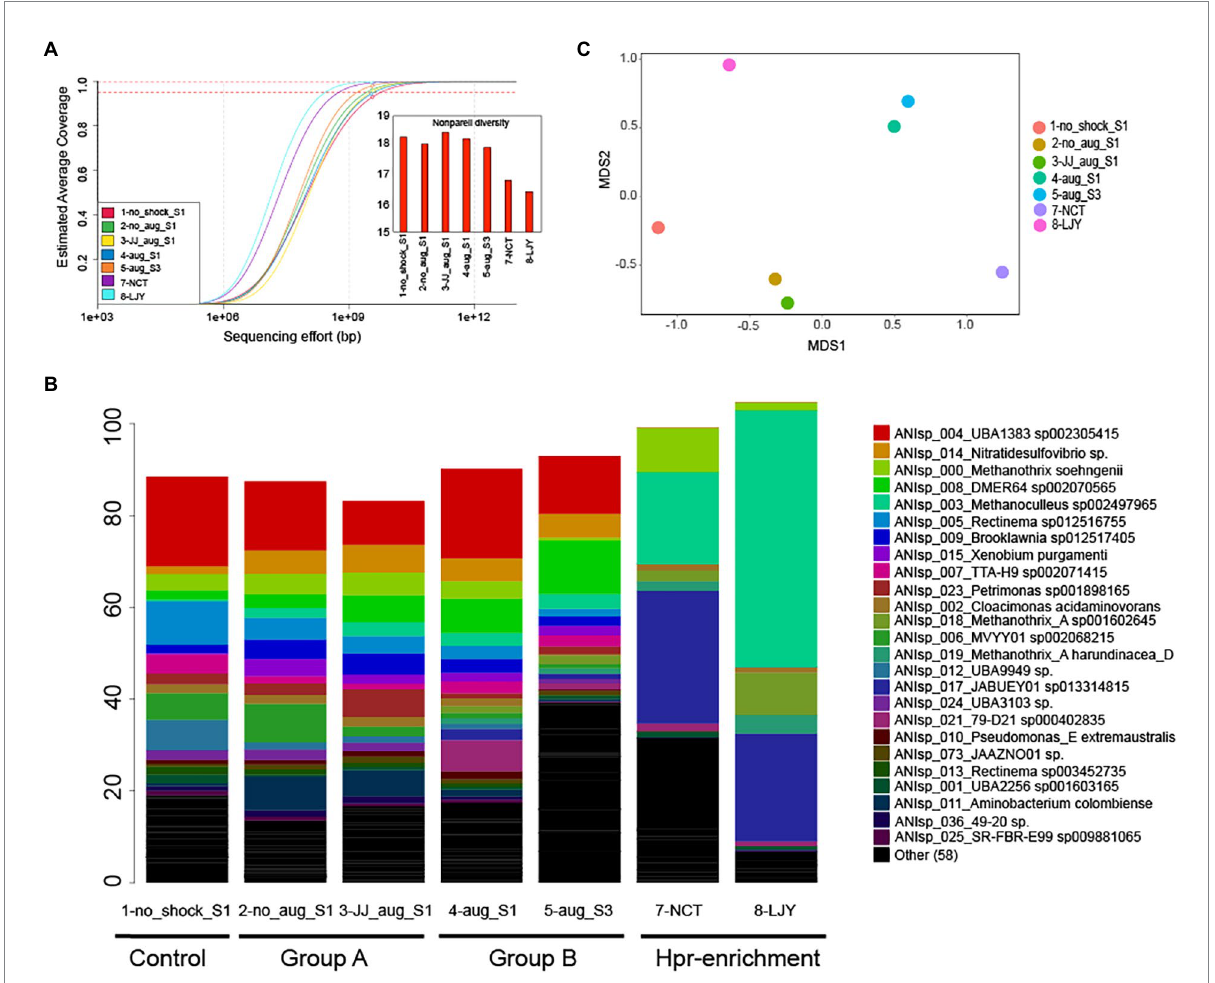
FIGURE 2 Microbial community diversity patterns and the relative abundance of genomospecies (MAGs). (A) Nonpareil curve and diversity of the samples used in this study ( n = 7). The circles represent the estimated coverage of the microbial community sampled by the sequencing depth/effort applied. The projected line to the right of the circle represents the expected coverage for higher sequencing efforts. Dashed lines represent the sequencing needed for 95 and 99% coverage levels. Curves positioned more on the right represent more sequence-diverse metagenomes compared to curves positioned on the left, and this information is represented as Nonpareil diversity (see the embedded bar chart). (B) Relative abundance patterns of genomospecies (MAGs). The relative abundance was estimated based on the normalized TAD80 metric as described in the Materials and Methods section. MAGs were named with unique identifiers (e.g., ANIsp_numbers) followed by the closest relative of the MAG according to the GTDBtk results. For instance, ANIsp_055_Syntrophobacteraceae sp. was used for a MAG that represented a novel species of the Syntrophobacteraceae family based on the lowest rank (family in this case) shared with its best match against GTDB. (C) A non-metric multidimensional scaling (NMDS) plot of microbial community similarity based on MASH distances of whole